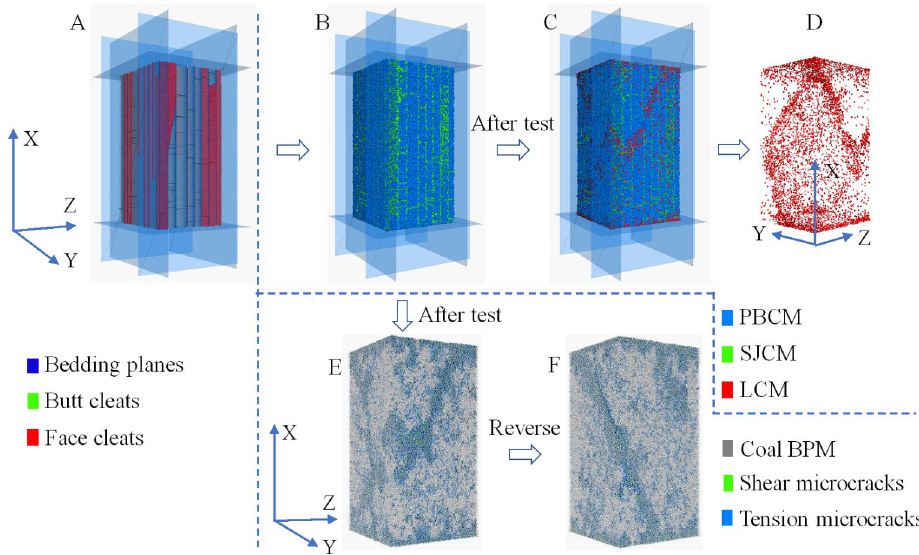
Fig. 11 Joint geometry and rup - ture surface for jointed coal with REV size subjected to numerical triaxial compression with loading perpendicular to butt